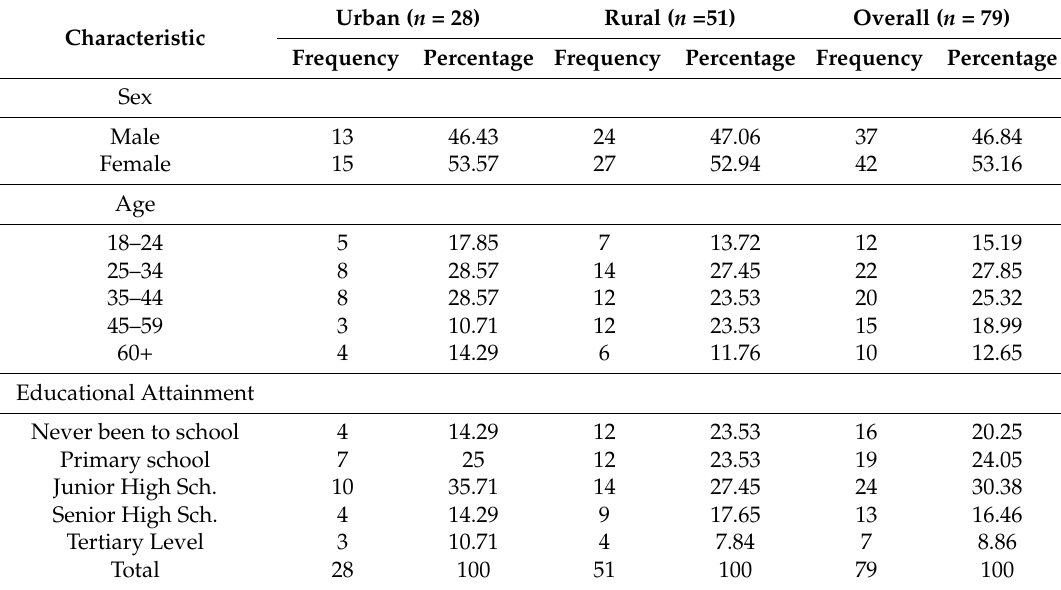
Table 1. Characteristics of Participants in the Study. Source: Authors’